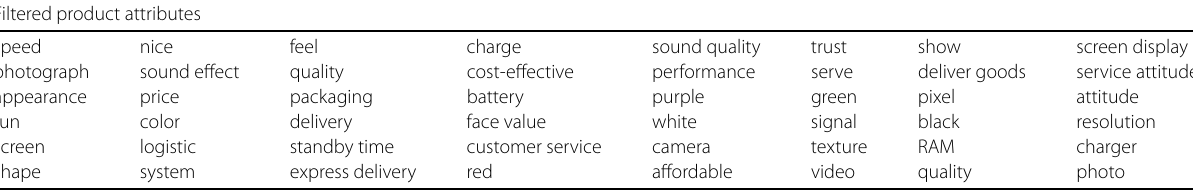
Table 3 Filtered product attributes Filtered product attributes